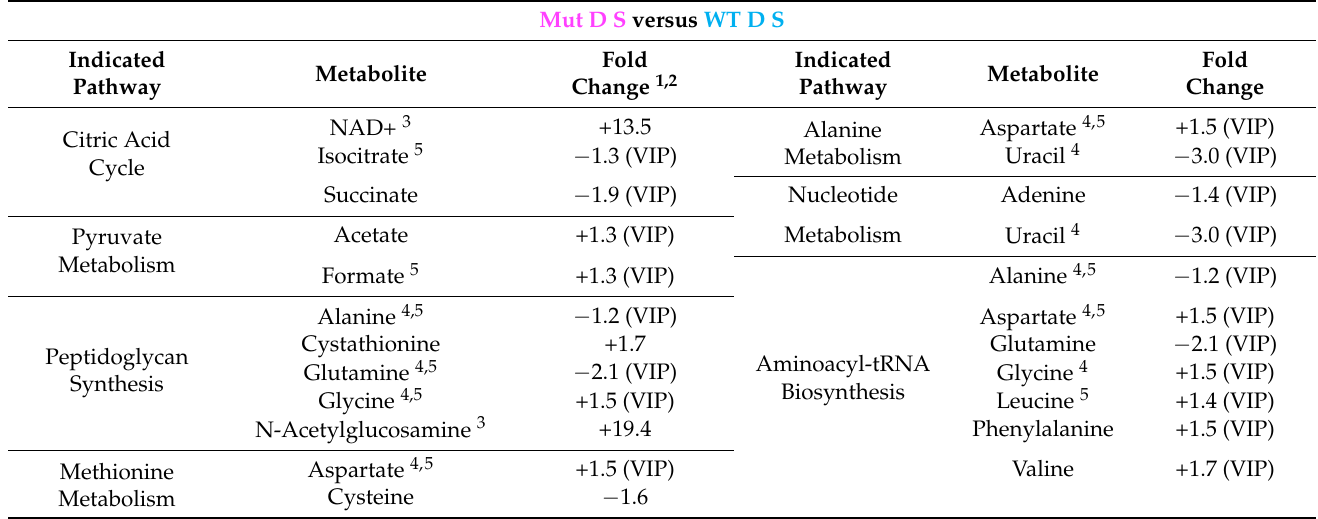
Table 5. Fold change of statistically significant metabolites in their corresponding metabolic pathways for the stationary phase of DABCOMD challenged mutant versus DABCOMD challenged wild type.